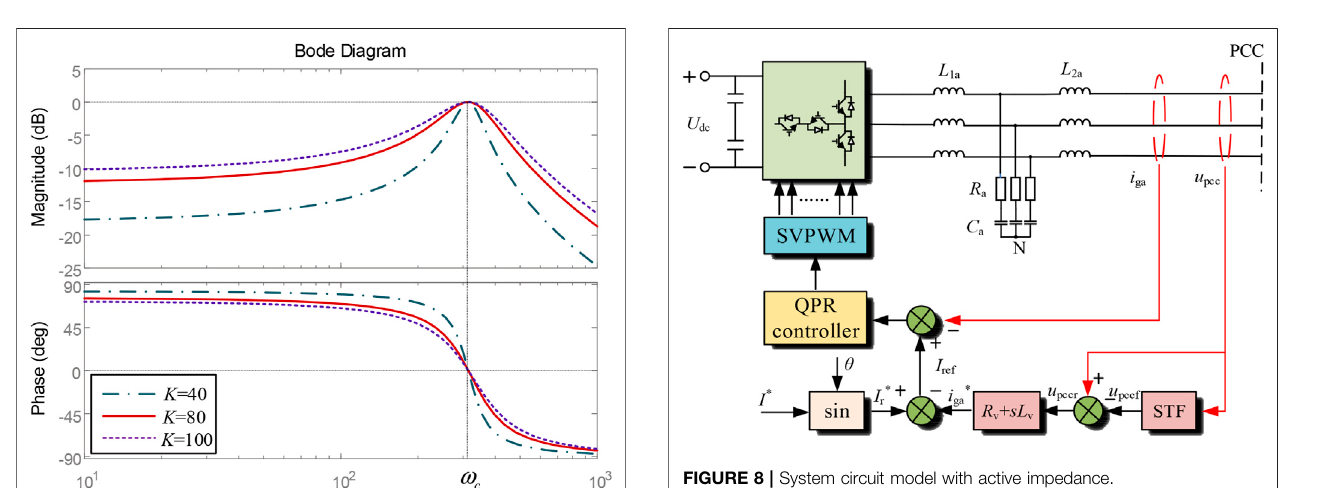
FIGURE 8 | System circuit model with active